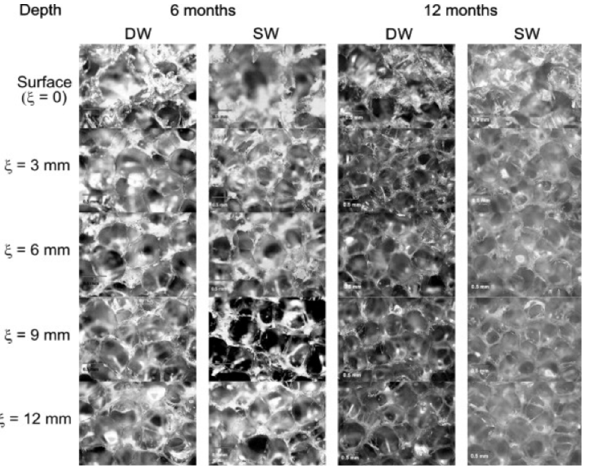
Figure 7. Optical micrographs of inner cross sections of the foam after 6 and 12 months of immersion. Scale bar is 0.5 mm. Reproduced from [69], with permission from Elsevier,